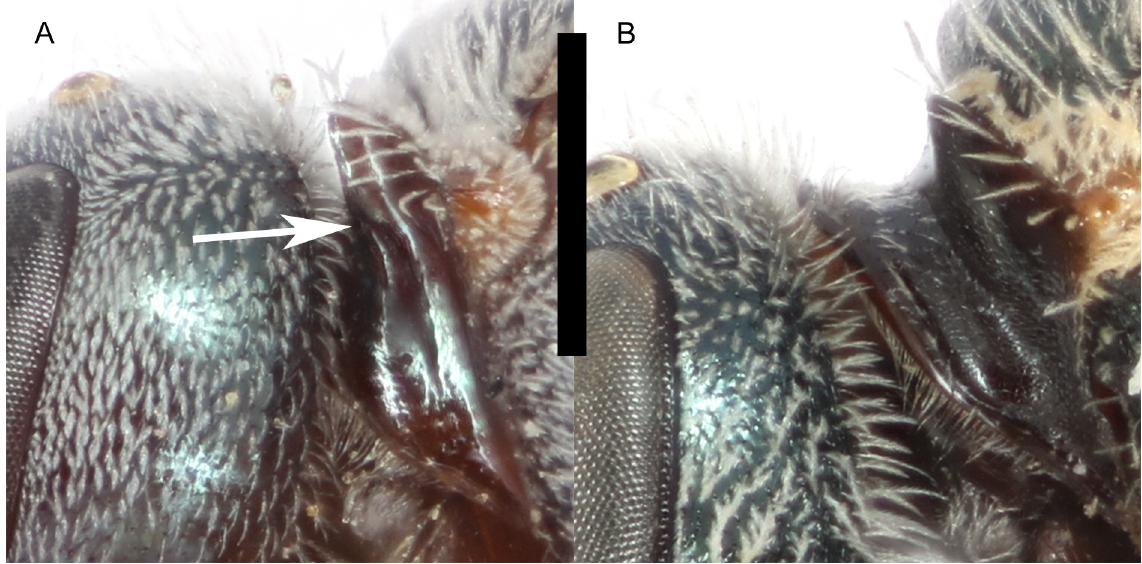
Fig. 109. Pronotal ridge (arrow). A . Lasioglossum ( D. ) kunzei (Cockerell, 1898), ♀, sharply carinate along full height of pronotum. B . L. ( D. ) eophilus (Ellis, 1914), ♀, absent. Scale bar: 0.5 mm.